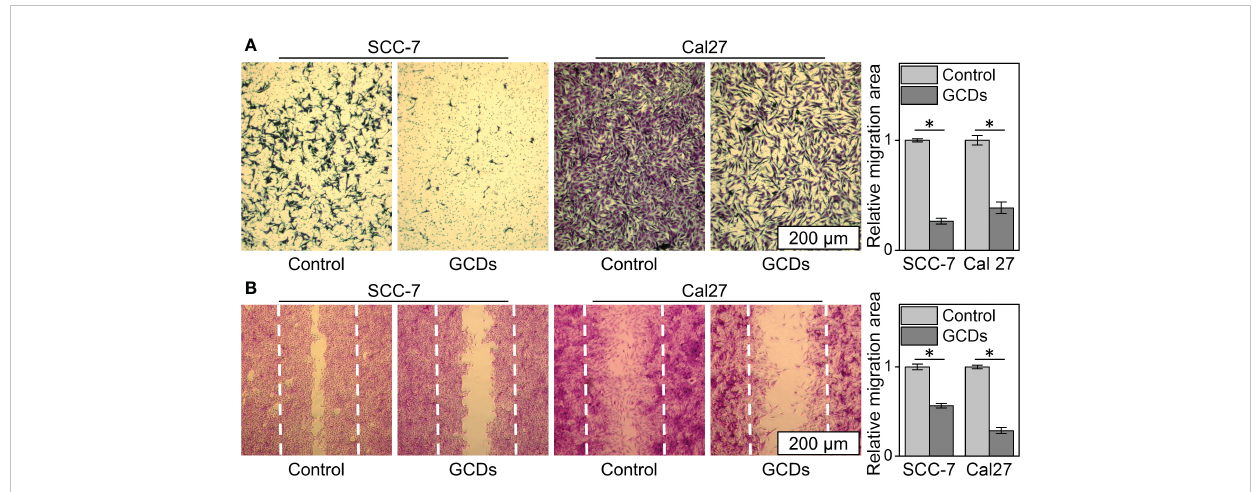
FIGURE 5 Ginseng-based carbon dots (GCDs) inhibit tumor invasion and migration. (A) Transwell assay of SCC-7 and Cal27 cells treated with GCDs (300 m g/mL). (B) Wound healing assay of SCC-7 and Cal27 cells treated with GCDs (300 m g/mL). Data are presented as mean ± SD from three experiments. *